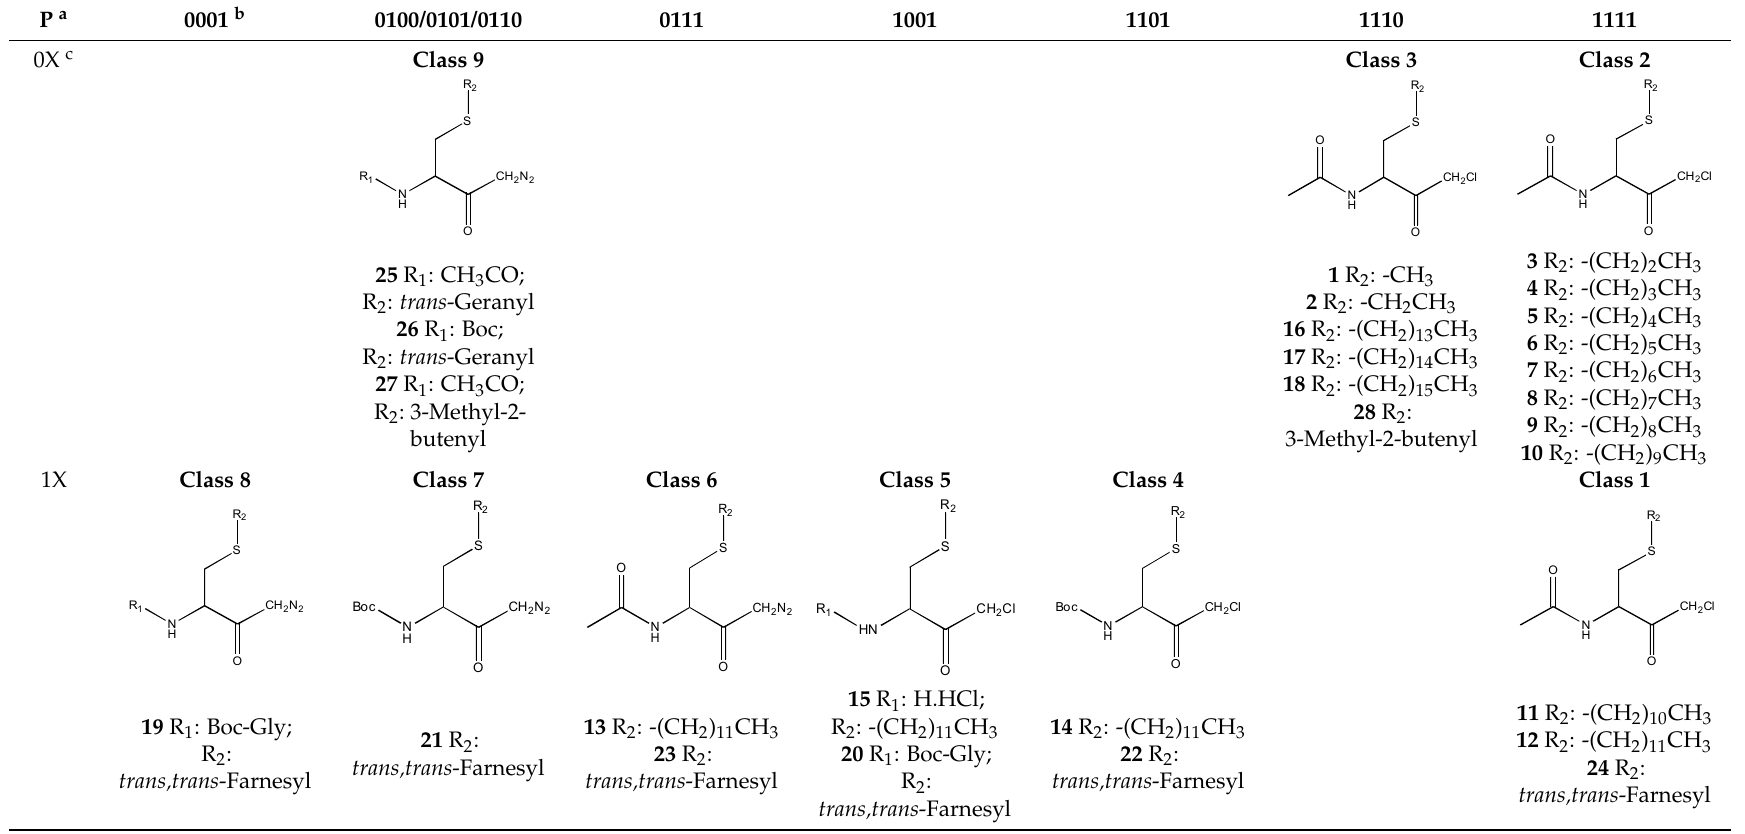
Table 2. Classification of cysteine diazomethyl- and chloromethyl-ketone derivatives by information entropy method. P